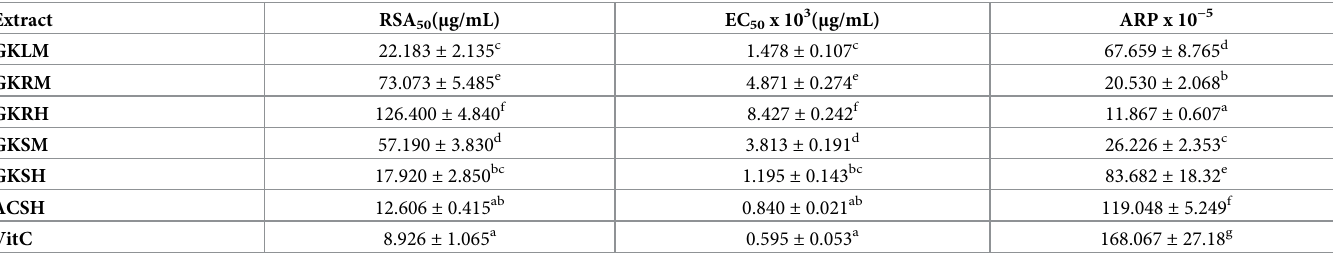
Along the line, values carrying the same letter superscripts are not significantly different (P > 0.05), Waller Duncan; RSA 50 , 50% Radical scavenging activity; EC 50 = 50% Efficient Concentration; ARP, Antiradical Power, GKLM: G . kola Leaf MeOH; GKRM: G . kola roots MeOH; GKRH: G . kola roots H 2 O/EtOH; GKSM: G . kola stem MeOH, GKSH: G . kola stem H 2 O/EtOH; ACSH: A . cordifolia stem H 2